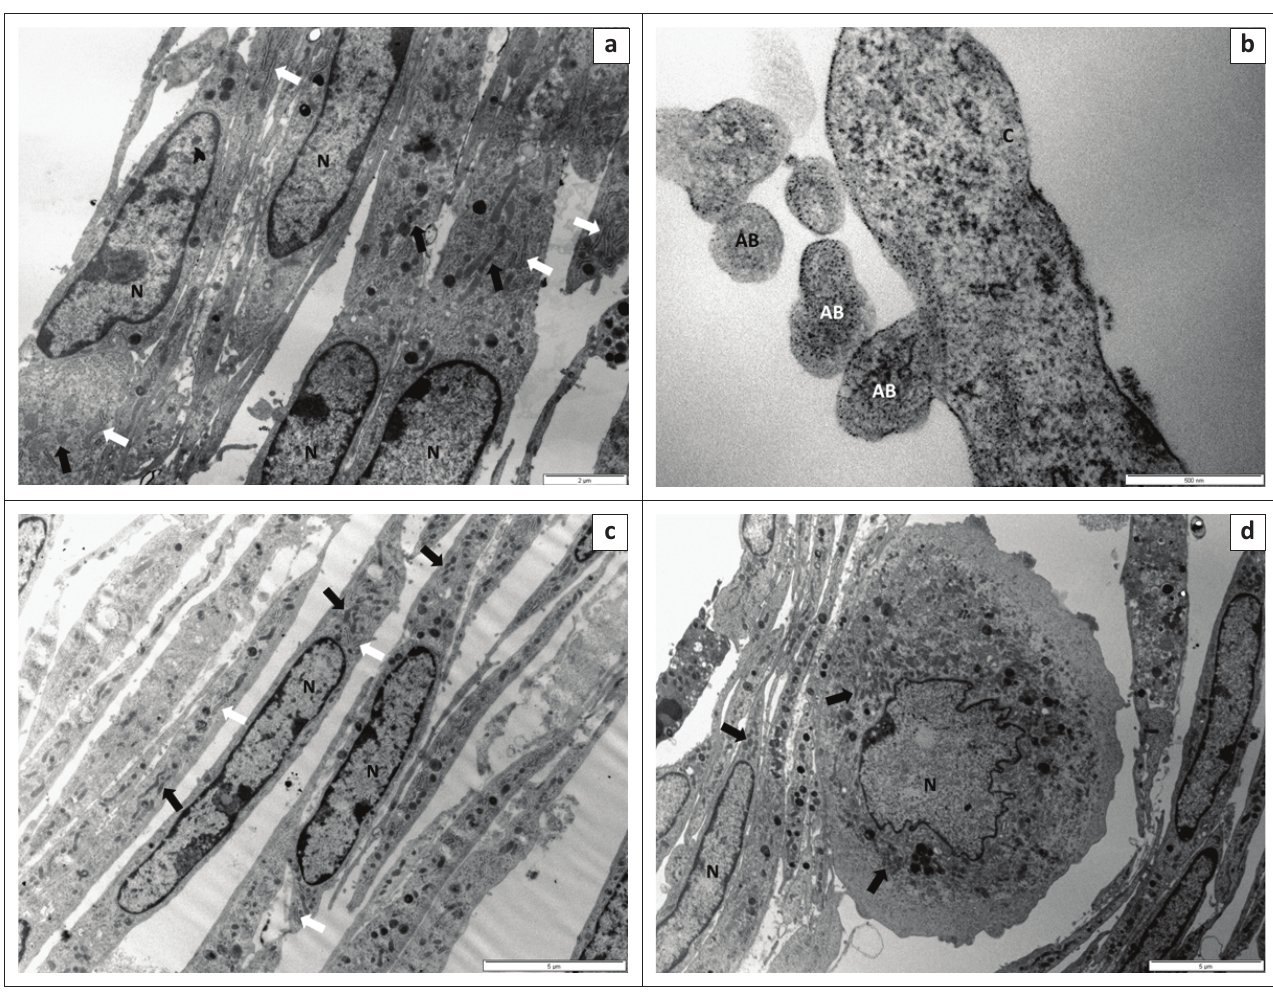
FIGURE 5: Electron micrographs showing C2C12 myoblasts exposed to 5.0 mM geigerin for 24, 48 and 72 h. (a) Control, (b) Geigerin 5.0 mM (24 h), (c) Geigerin 5.0 mM (48 h) and (d) Geigerin 5.0 mM (72